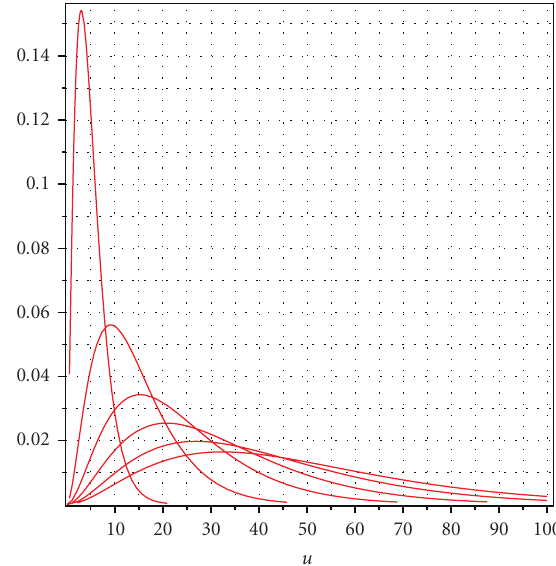
Figure 3: Gamma PDF curves for di ff erent parameters’